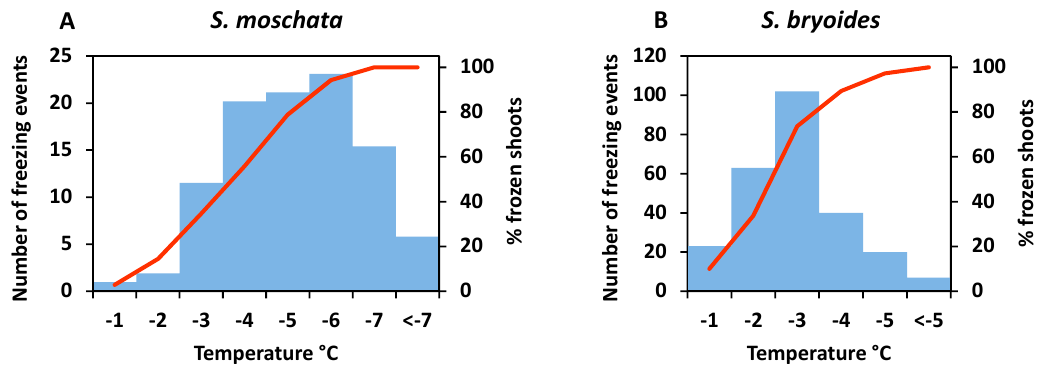
Figure 5. Number of freezing events (blue columns) and percent frozen shoots (red line) with successively decreasing freezing temperatures in an individual of ( A ) Saxifraga moschata Wulfen and ( B ) Saxifraga bryoides L., determined by IDTA.